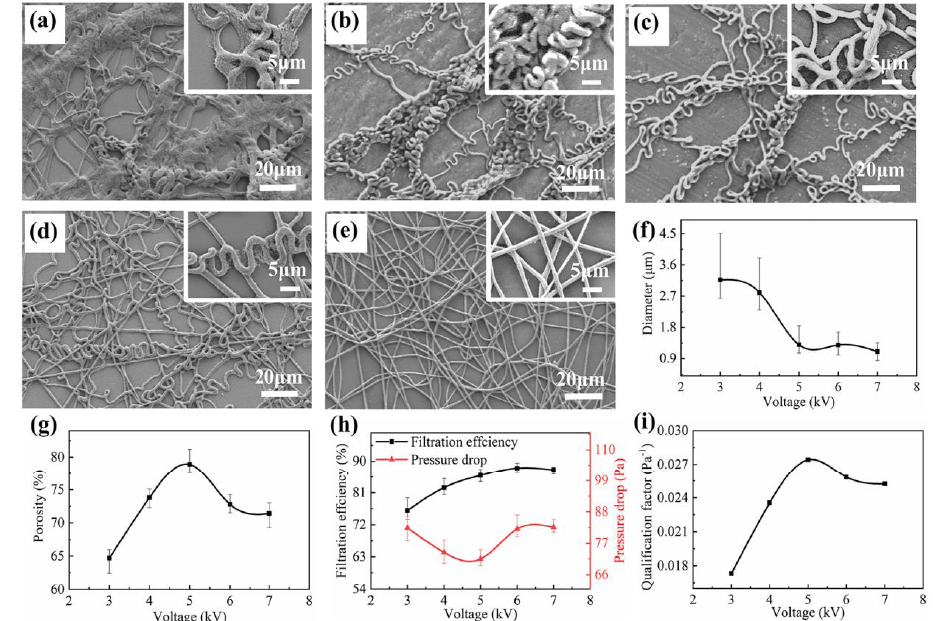
Figure 6. The SEM image, nanofiber diameter and filtration performance of nanofibrous membrane with different applied voltage. ( a – e ) SEM image of PVDF nanofibrous membrane at the voltage of 3.0 kV, 4.0 kV, 5.0 kV, 6.0 kV and 7.0 kV, respectively; ( f – i ) diameter, porosity, filtration efficiency and pressure drop, QF of PVDF nanofibrous membrane at different voltage, respectively. The distance between electrode and collector, the roller speed and the electrospinning time was 3.0 cm, 50 rpm and 60 min, respectively.